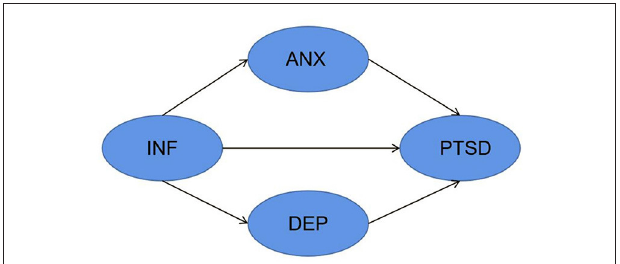
FIGURE 2 | Research model. INF, COVID-2019 information overload; ANX, anxiety; DEP, depression; PTSD, post-traumatic stress disorder.